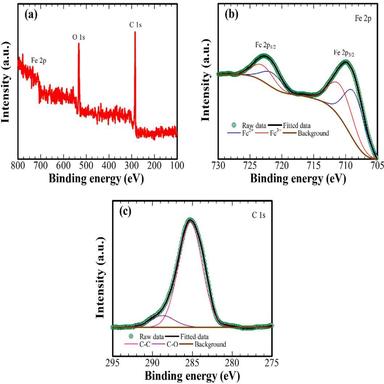
XPS spectrums of the C/Fe3O4 microspheres prepared by steam oxidation: wide-scan (a), narrow-scan of Fe 2p (b), and narrow-scan of C 1s (c).